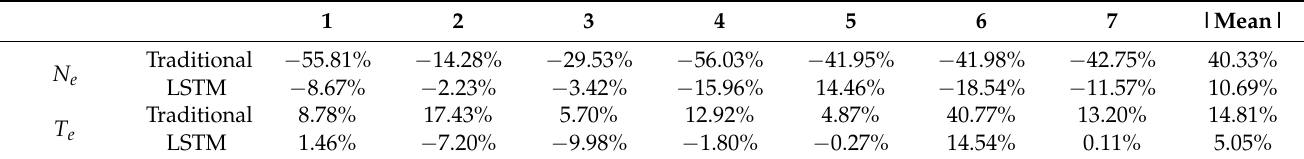
Figure 11. ( a ) The comparison results of the N e ; ( b ) The comparison results of the T e . Table 3. Comparison of errors in predicting electron density ( N e ) and electron temperature ( T e ) using traditional diagnostic methods and